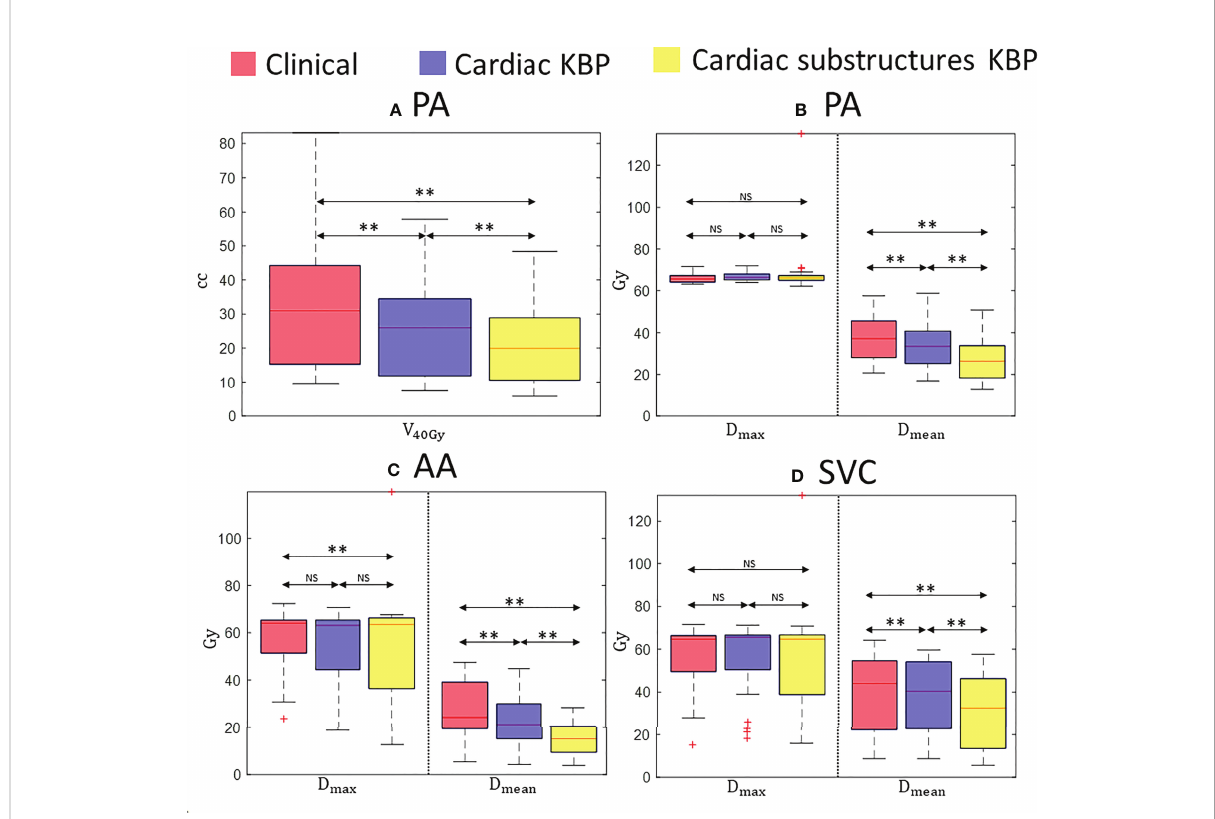
FIGURE 4 Box plots for volume of PA covered by 40 Gy isodose line (A) , maximum and mean dose to PA (B) , AA (C) , and SVC (D) over 28 treatment plans generated by clinically optimized (orange), C-KBP (purple), and CS-KBP (yellow). The central mark indicates the median, and the bottom and top edges of the box indicate 25th and 75th percentile, respectively. The whiskers extend to the most extreme data points not considered outliers, and the outliers are plotted individually using the ‘ + ’ marker symbol. p < 0.05 is denoted as ‘ * ’ ; p < 0.01 is denoted as ‘ ** ’ ; NS = Not Signi fi